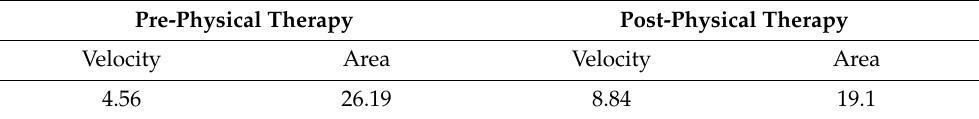
Table 2. Alternate Romberg Ratio (QR).